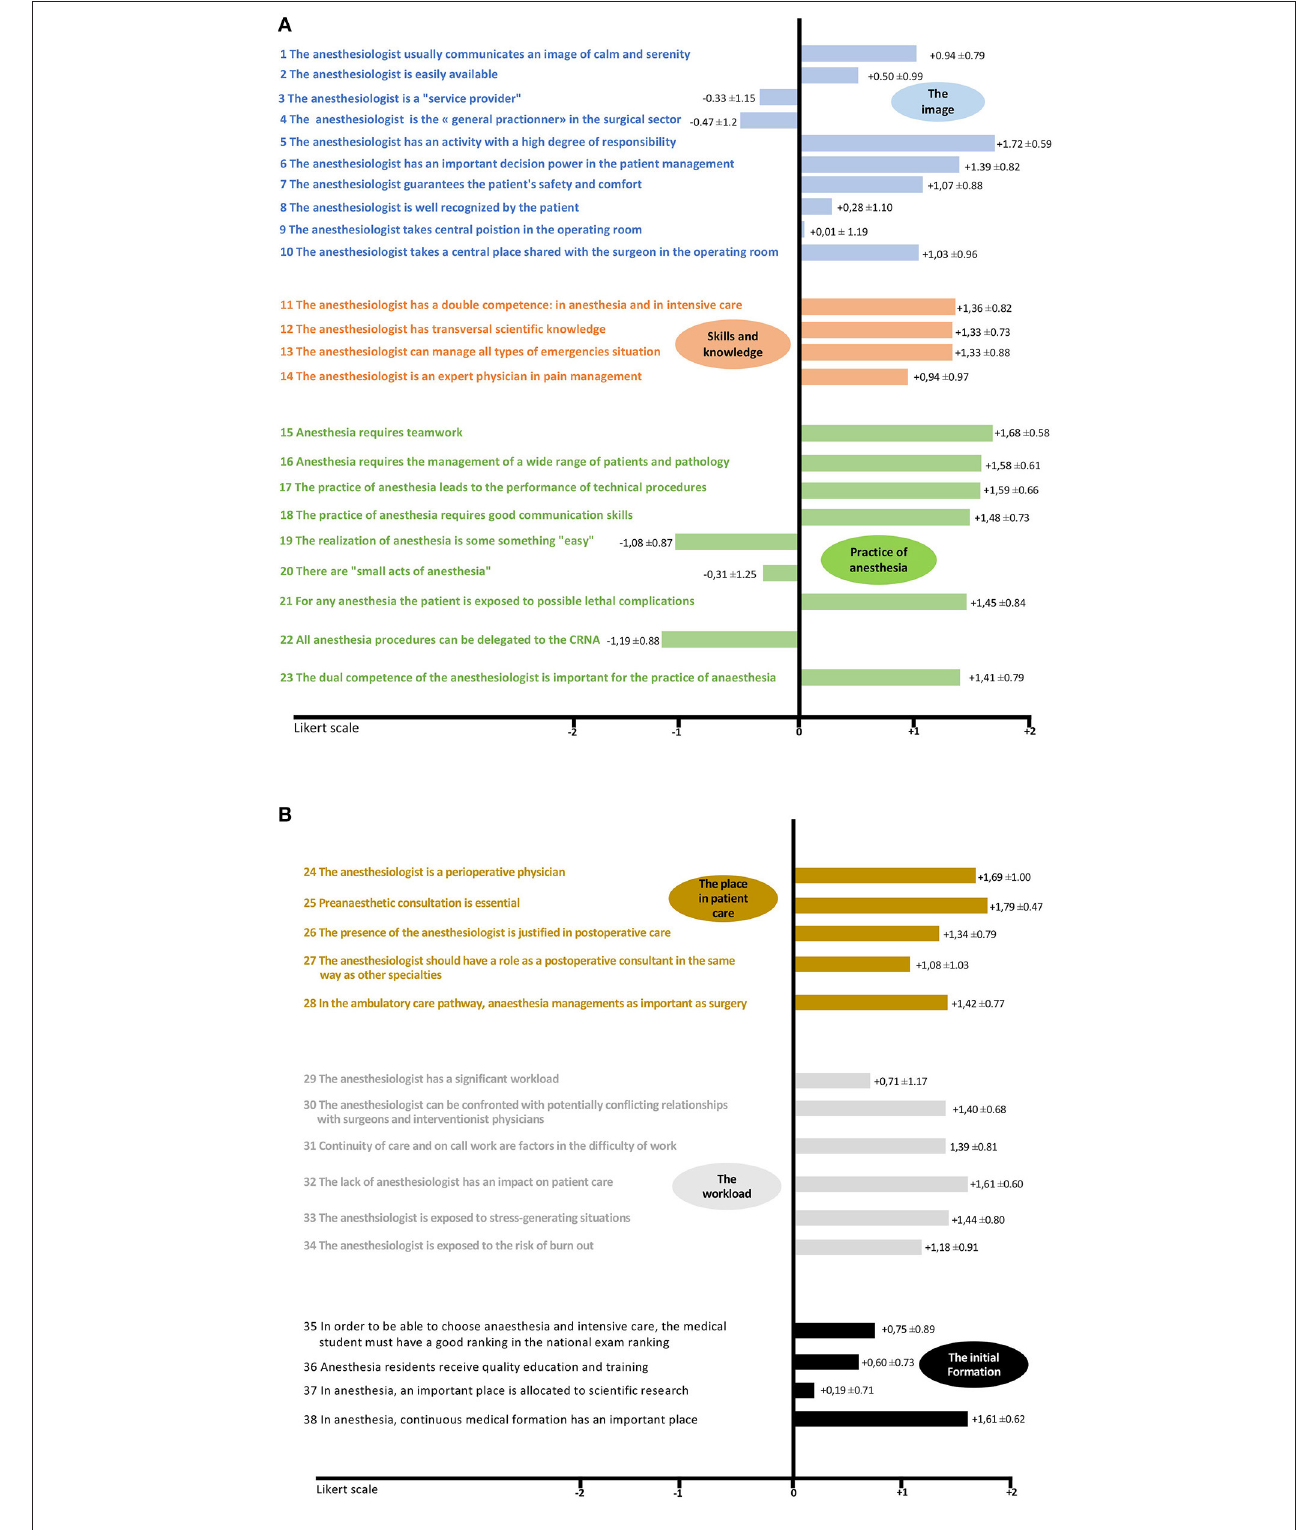
FIGURE 2 | (A) Mean evaluation for each question of the survey on a Likert scale from − 2 to + 2. (B) Mean evaluation for each question of the survey on a Likert scale from − 2 to + 2.